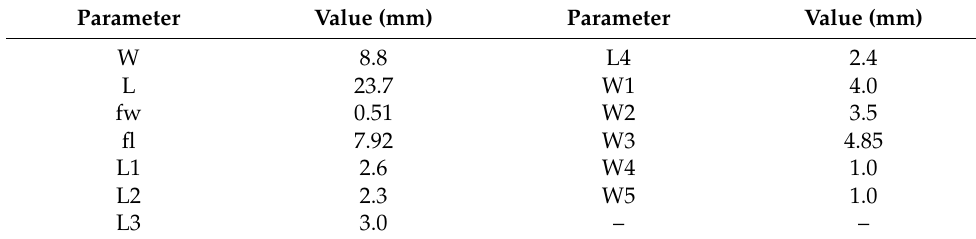
Figure 1. Geometry of the proposed antenna element. Table 1. Geometric parameters of the proposed antenna